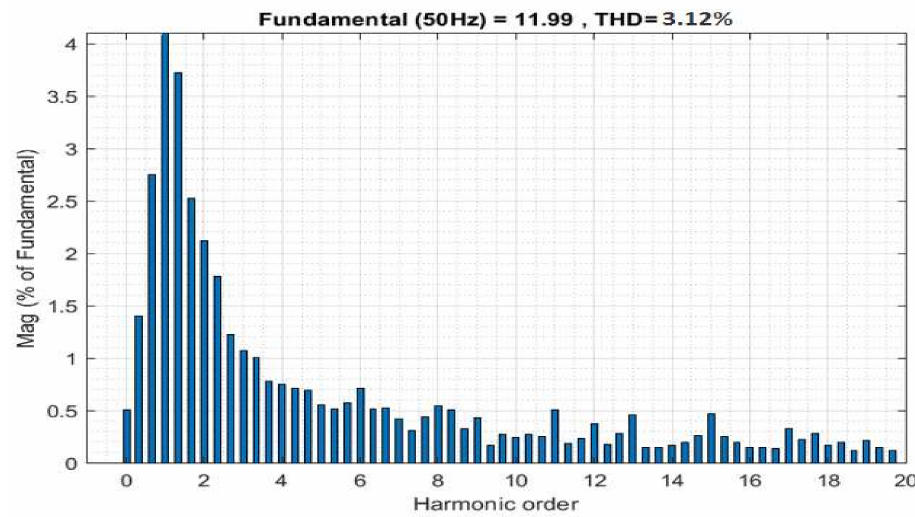
Figure 13. THD analysis.